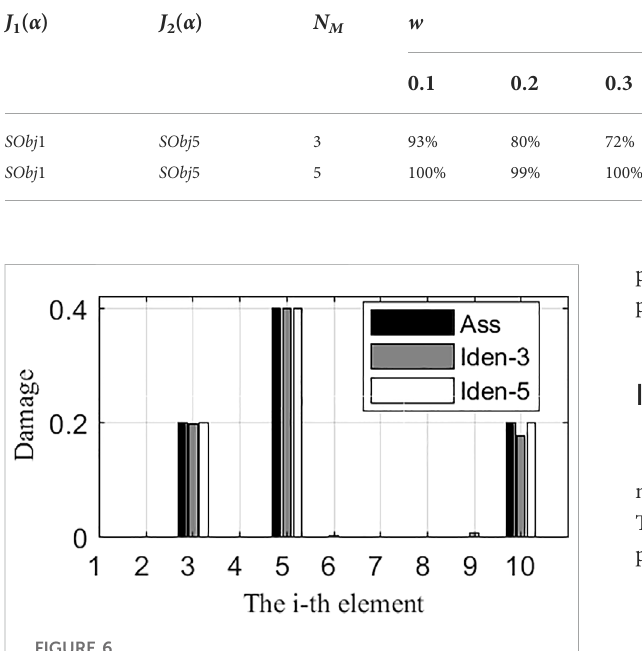
FIGURE 6 Mean values of SDD results in case 3 based on (0.1* SObj 1 + 0.9* SObj 5)